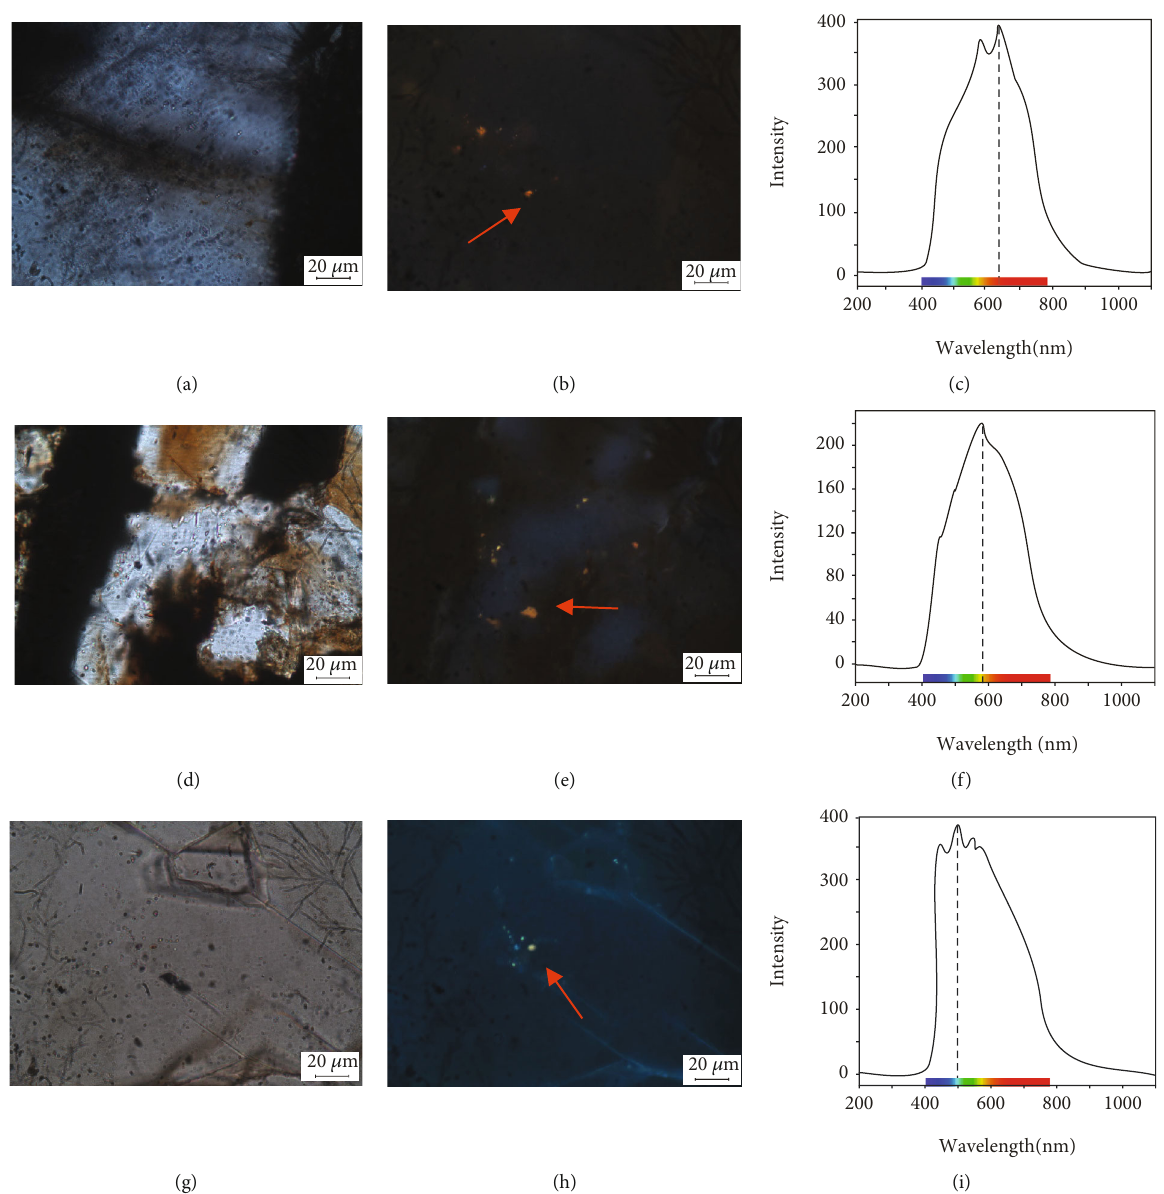
Figure 8: Micro fl uorescence and spectral characteristics of hydrocarbon inclusions captured by calcite in Lucaogou Formation, Jimsar